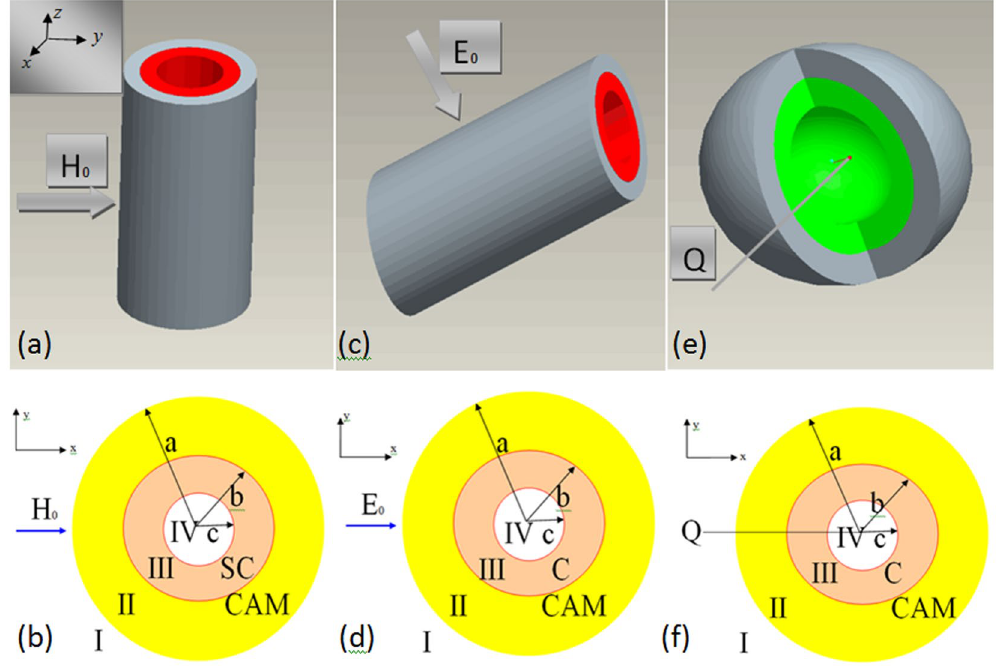
Figure 1. The bi-layer cylindrical and spherical cloak. ( a ) The 3D CAM and superconductor bi-layer cylindrical magnetic cloak. ( b ) The cross section (z = 0, axial) in ( a ), the “SC” stands for superconductor, a uniform (cid:31) (cid:30)(cid:31) magnetic field H 0 is applied on the cylindrical magnetic cloak. ( c ) The 3D CAM and conductor bi-layer cylindrical electric cloak. ( d ) The cross section (z = 0, axial) in ( c ), the “C” stands for conductor, a uniform (cid:31)(cid:30)(cid:31) magnetic field E 0 is applied on the cylindrical electric cloak. ( e ) The 3D CAM and conductor bi-layer spherical electric cloak. ( f ) The cross section (z = 0) in ( e ), a point electric charge Q is in front of the spherical electric